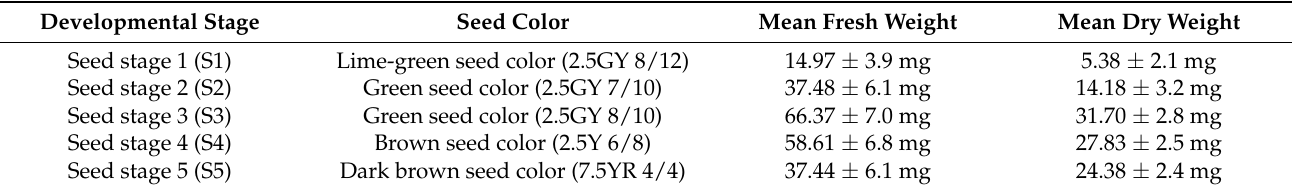
Table 3. Characteristics of A. pelegrina seeds by developmental stage. Mean ± standard deviation.